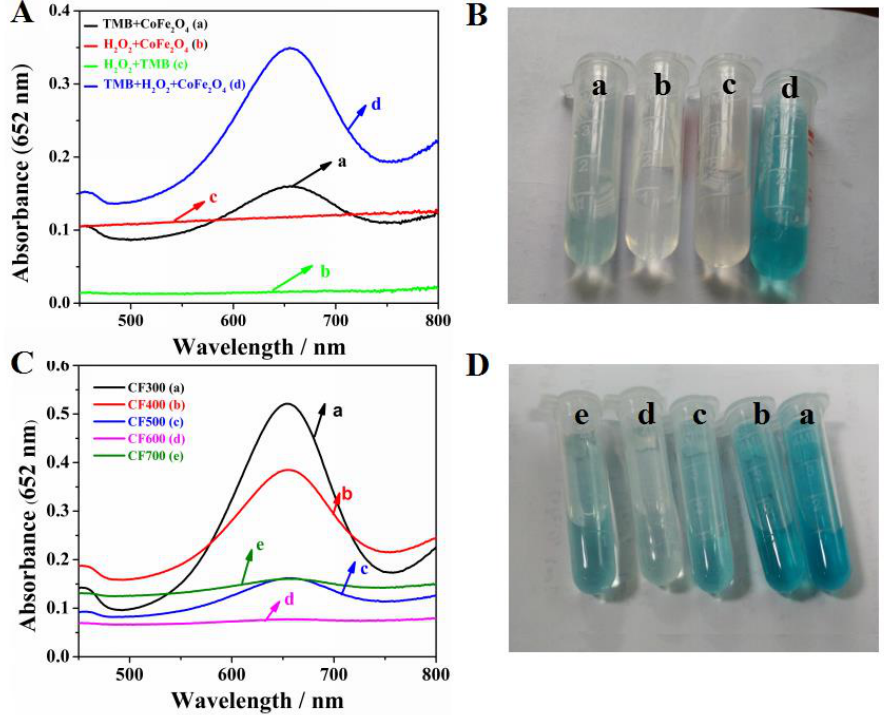
Figure 6. ( A ) UV-vis absorption spectra and ( B ) color changes in different reaction systems (a. TMB + CF400; b. H 2 O 2 + CF400; c. H 2 O 2 + TMB; d. TMB + H 2 O 2 + CF400); ( C ) UV-vis absorption spectra and ( D ) color changes in the presence of different CoFe 2 O 4 samples (a. CF300; b. CF400; c. CF500; d. CF600; e. CF700).